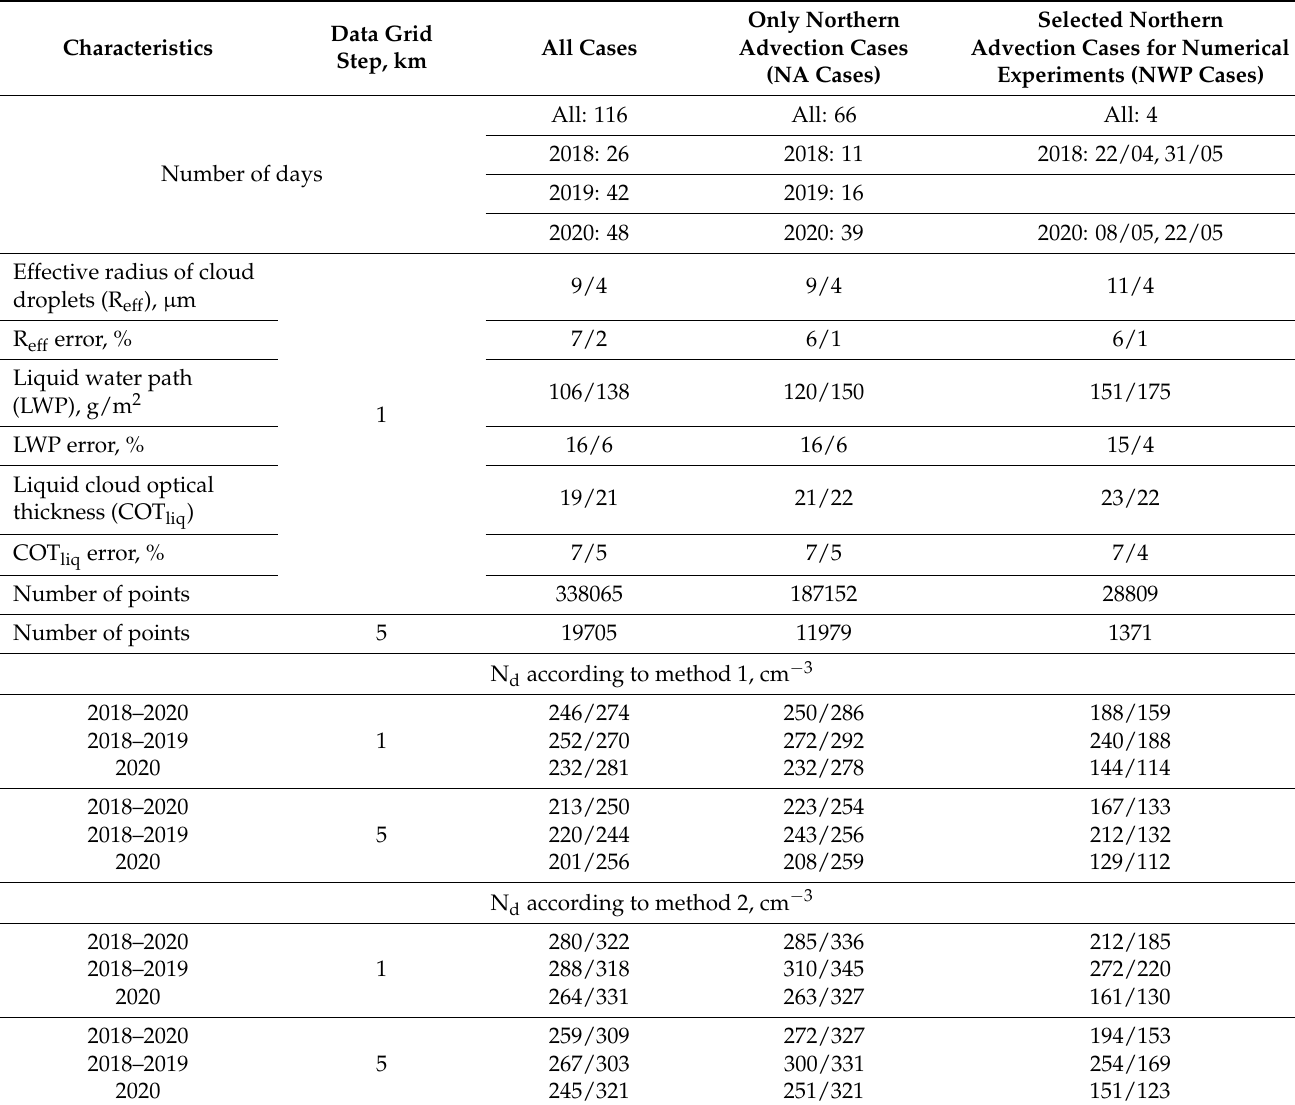
Table 2. Median and interquartile range (shown through a slash “/”) of the observed and retrieved cloud characteristics for the samples. Errors were provided with the data by the